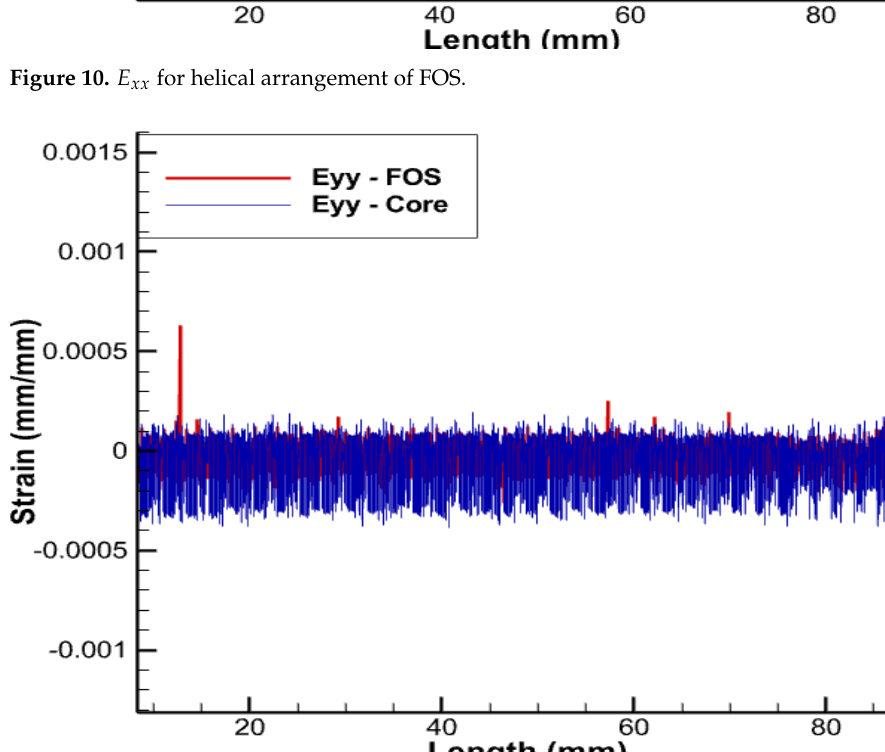
Figure 11. E yy for helical arrangement of